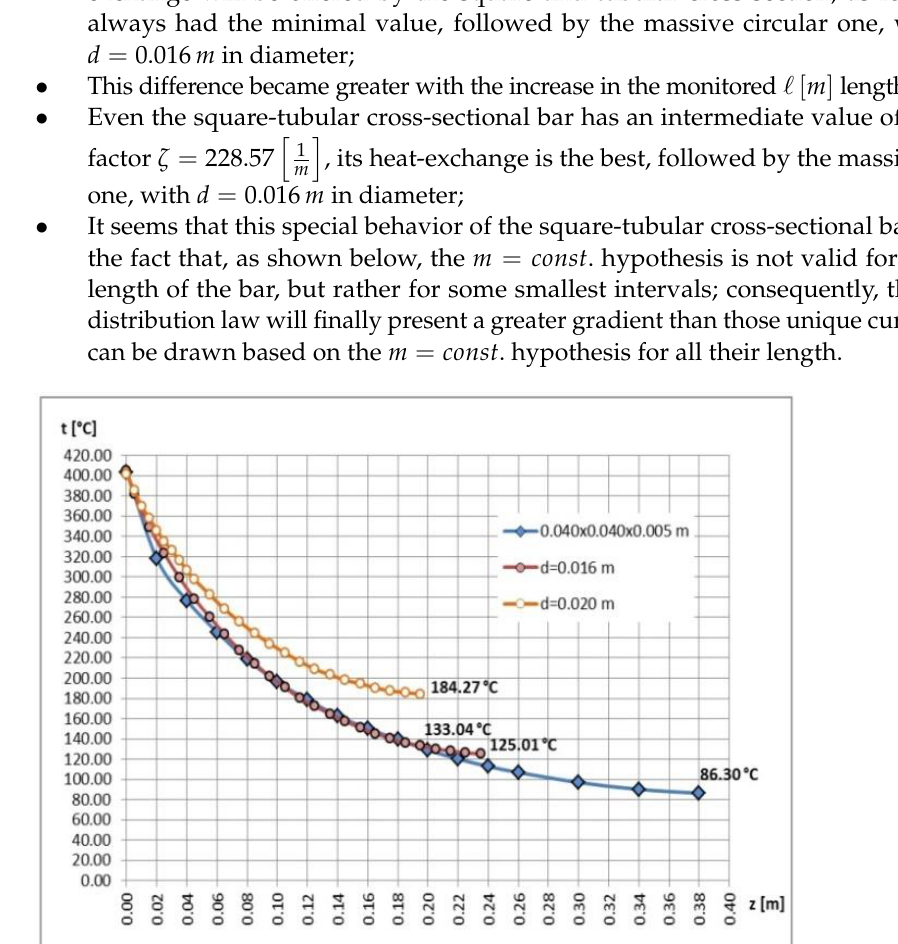
Figure 10. The comparative, effectively measured thermal distribution laws for α g = 0 ◦ and t O , n = 400 ◦ C.